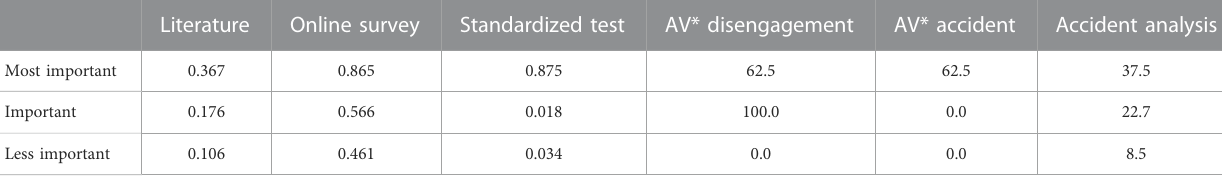
TABLE 6 Statistical comparison between clusters with different importance